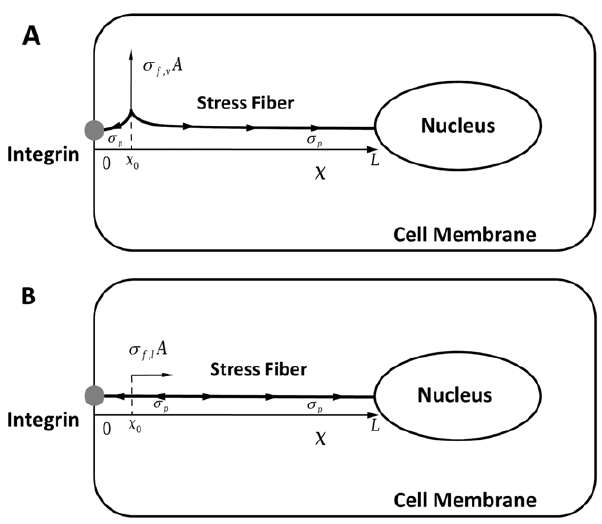
Figure 1. Schematic diagram of the present model for ( A ) transverse and ( B ) axial motion. The integrin is positioned at x ~ 0 and the nuclear edge at x ~ L . An actin stress fiber of length L ~ 10 m m directly links the integrin to the nucleus. A prestress s p ~ 3 | 10 5 Pa is assumed to be uniformly distributed throughout the stress fiber. The transverse and axial forces are applied at x 0 ~ 1 m m .